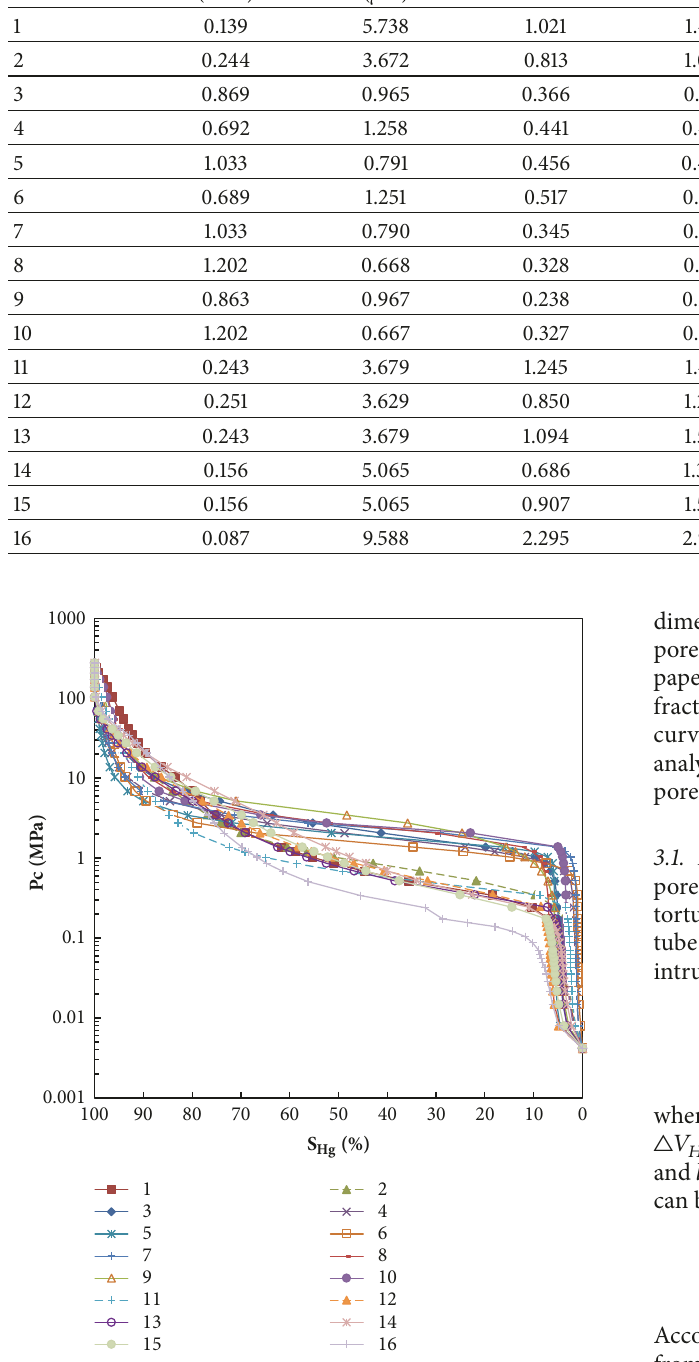
Figure 2: Mercury intrusion capillary pressure curves of 16 carbon- ate core